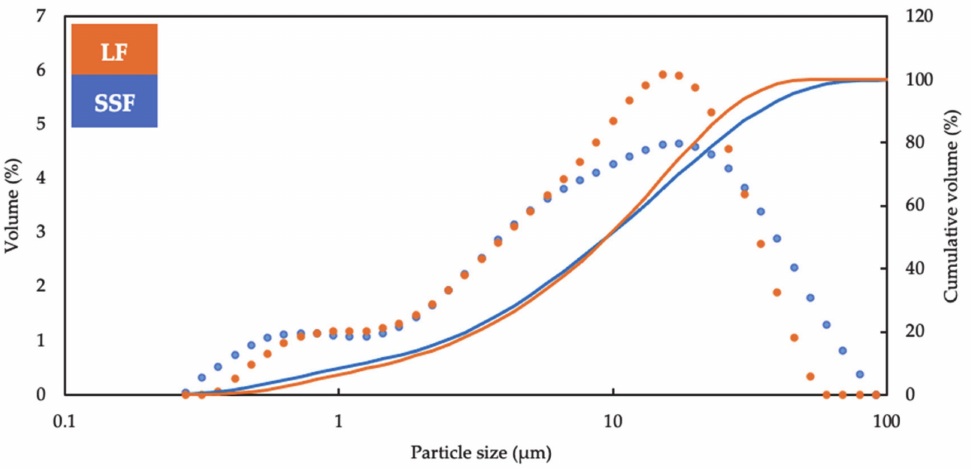
Figure 2. Particle size distribution of SSF and